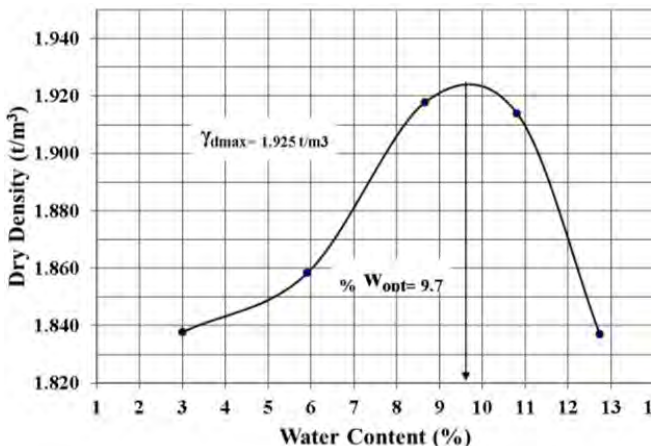
Figure 20. Modified proctor test for specimens from 67.3E km to 69.1E km at Elferdan